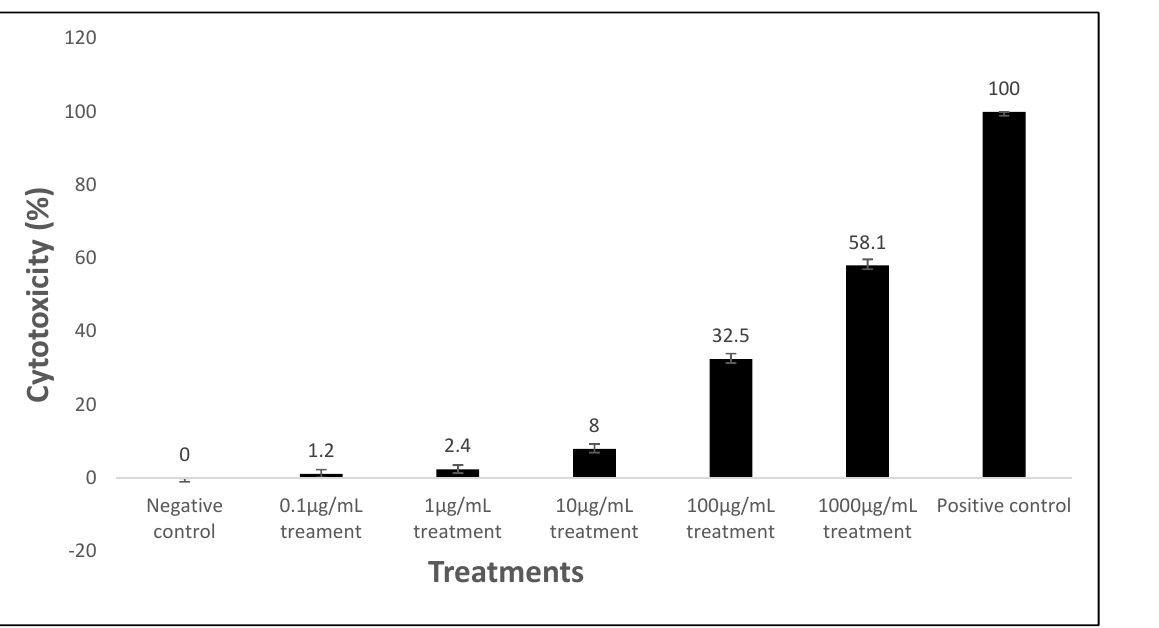
Figure 5. Cytotoxic effect of the varying concentrations of maraviroc and tenofovir microspheres, negative and positive control on the HeLa cell lines. Results are given as mean ± SD, n = 3.